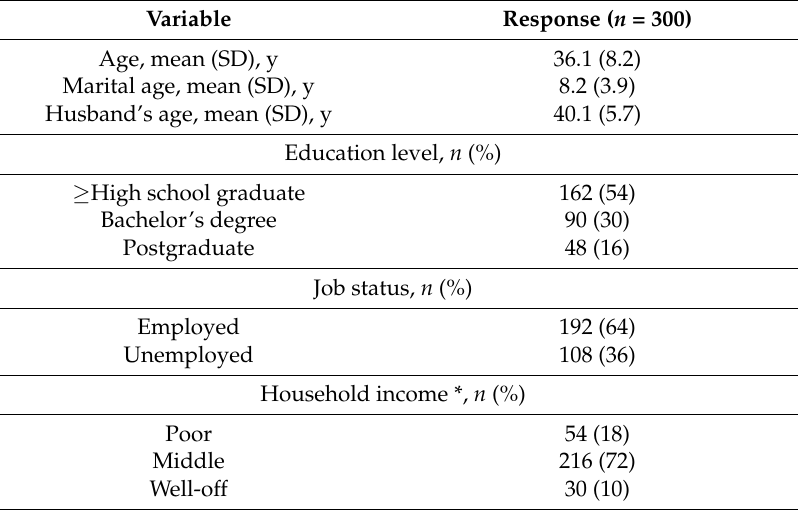
Table 1. Characteristics of the subjects in this